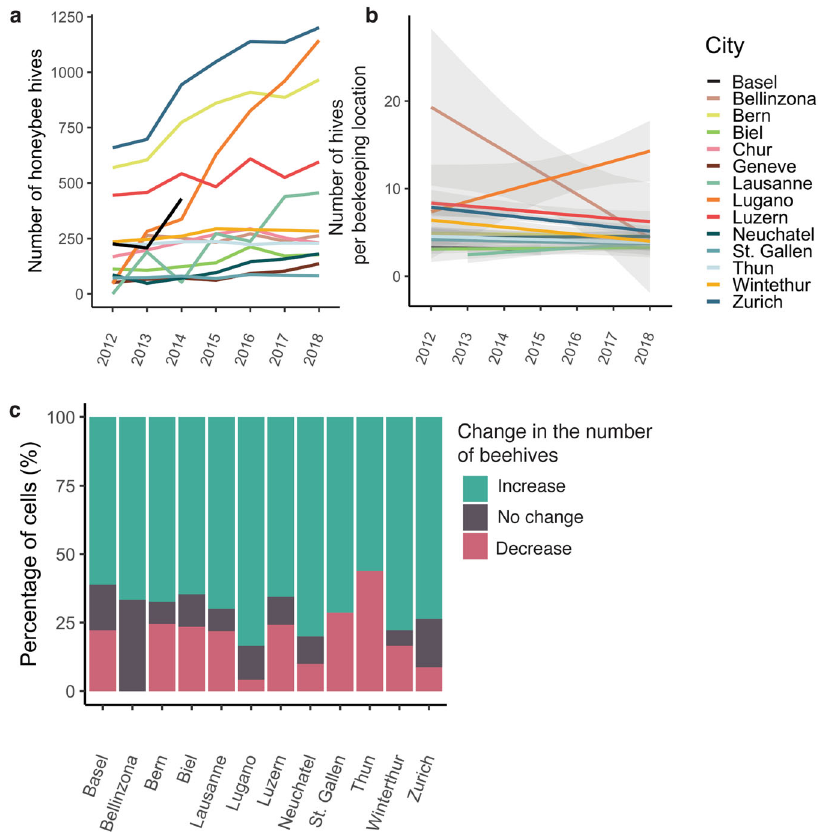
Fig. 1 Urban beekeeping trends in Swiss cities for the period 2012 – 2018. a Number of honeybee hives per year for all 14 Swiss cities. Each line and colour represents a single city. b Response curves showing the number of hives per beekeeping location per year for all of the Swiss cities except Geneva and Chur (where spatially explicit data were of low quality). Lines represent linear models and bands indicate 95% con fi dence intervals. Each line and colour represents a single city. c Percentage of cells in each city with an increase (green), decrease (red) or no change (dark grey) in the number of hives. See also Supplementary Tables 1 and 2 and Supplementary Fig.